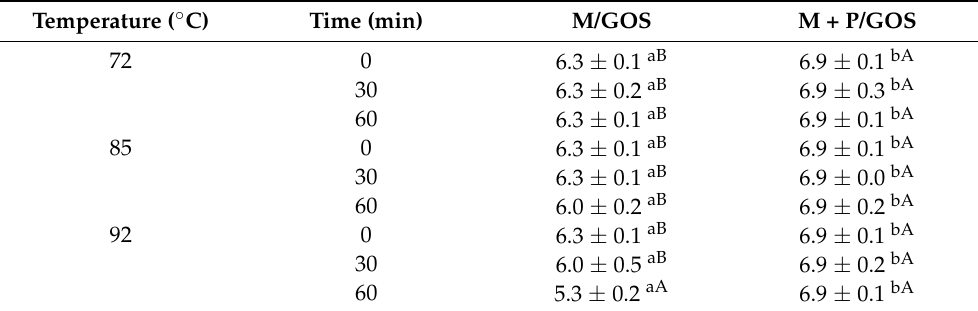
Table 4. Galactooligosaccharide (GOS) content in total sugars (%) in goat’s milk and goat’s milk with permeate after enzymatic conversion of